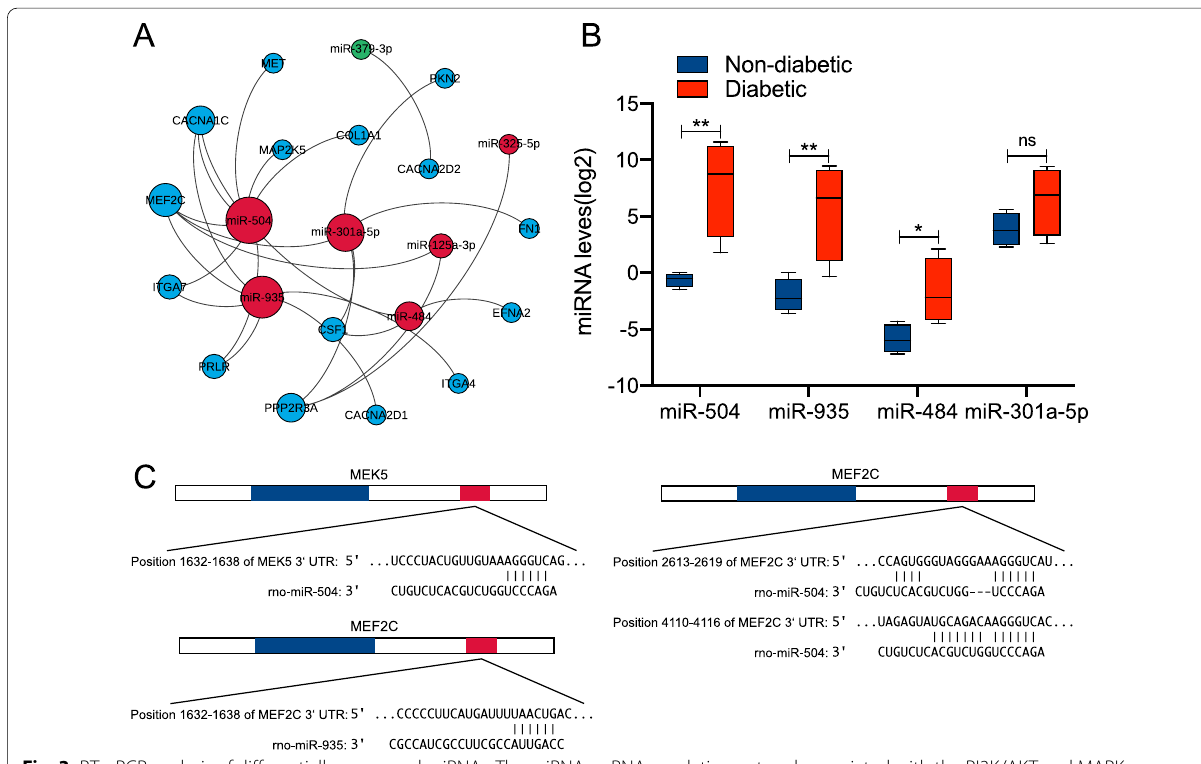
Fig. 3 RT-qPCR analysis of differentially-expressed miRNAs. The miRNA–mRNA regulation network associated with the PI3K/AKT and MAPK pathways were constructed using the Gephi software ( A ). RT-qPCR analysis of differentially-expressed miRNAs (miR-504, miR-935, miR-484, miR-301-5p) in the serum of normal glucose tolerance subjects and type 2 diabetic patients ( B ). Data are presented as box plots, where all fold changes were calculated between medians. The y-axis indicates the expression level of miRNAs on a log2 scale. *p < 0.05, **p < 0.01, NS, not significant. The binding sites of miR-504 and miR-935 in the 3’-UTR of MEK5 and MEF2C mRNA were predicted using miRNA target prediction